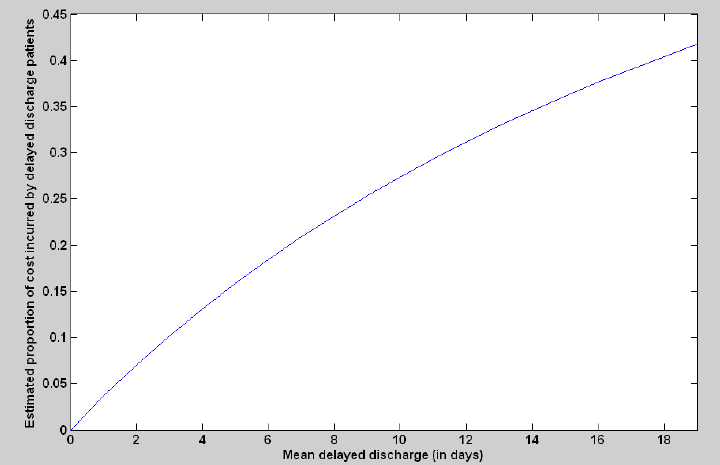
Figure 12. The estimated proportion of cost incurred by delayed discharge patients (after 1000 days since the first patient gets delayed).